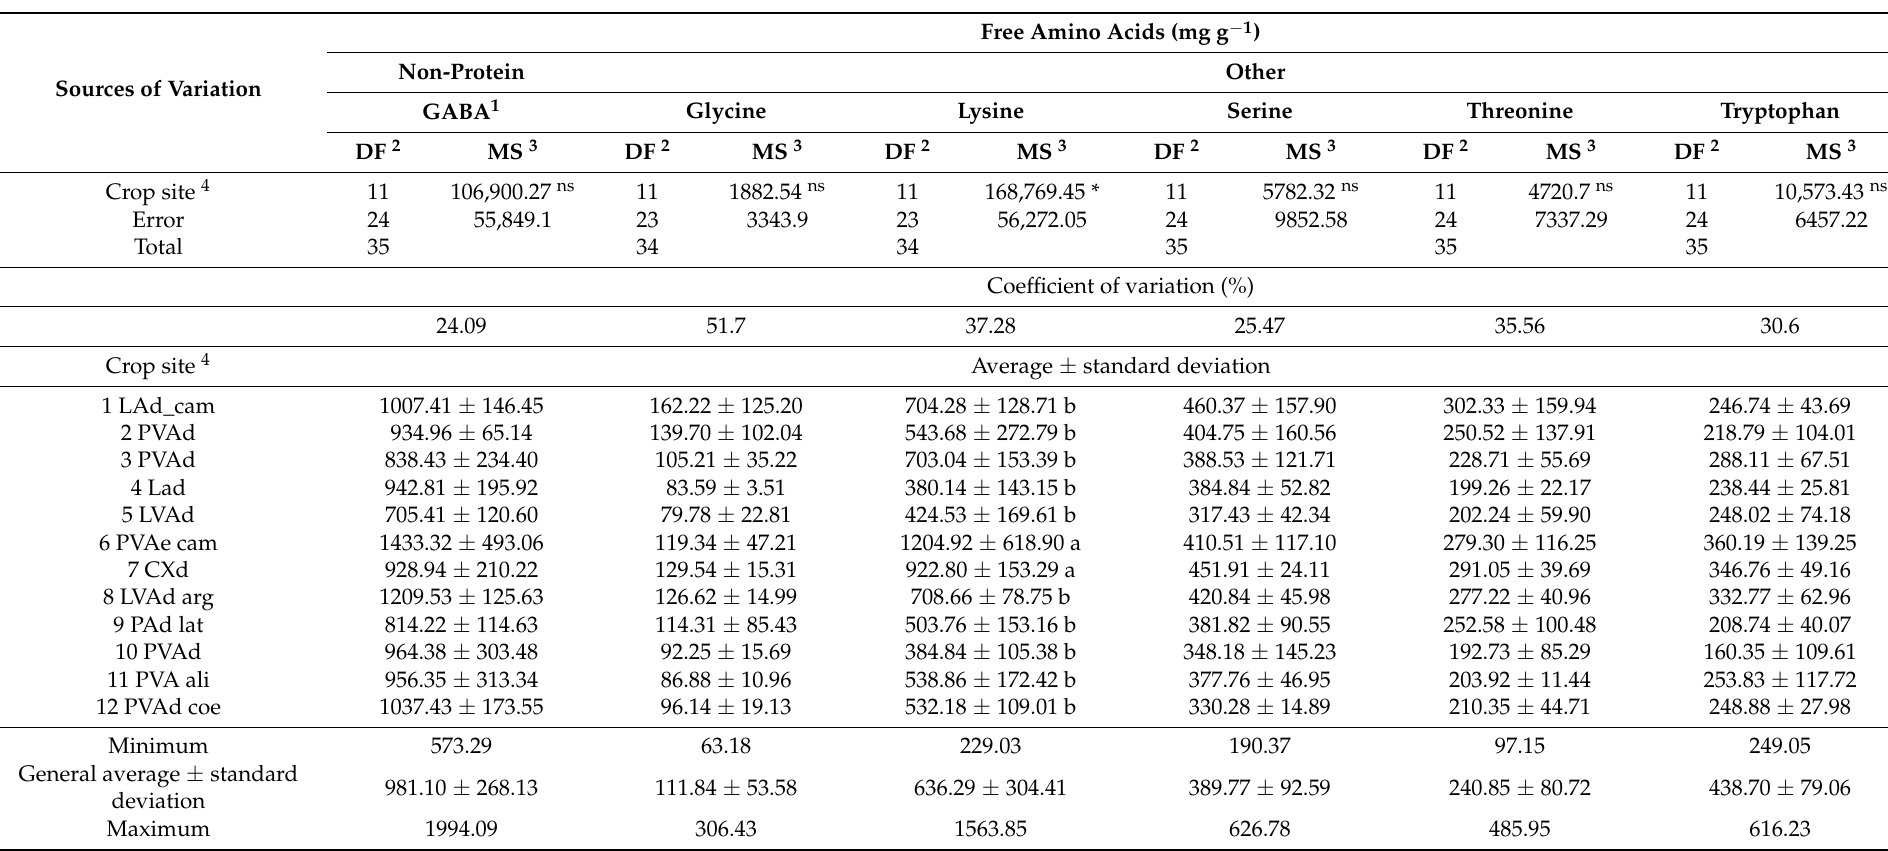
Table 4. Effect of different edaphic crop conditions in the humid zone of southeast Bahia, Brazil on non-protein and other free amino acids of PH-16 dry cacao beans.